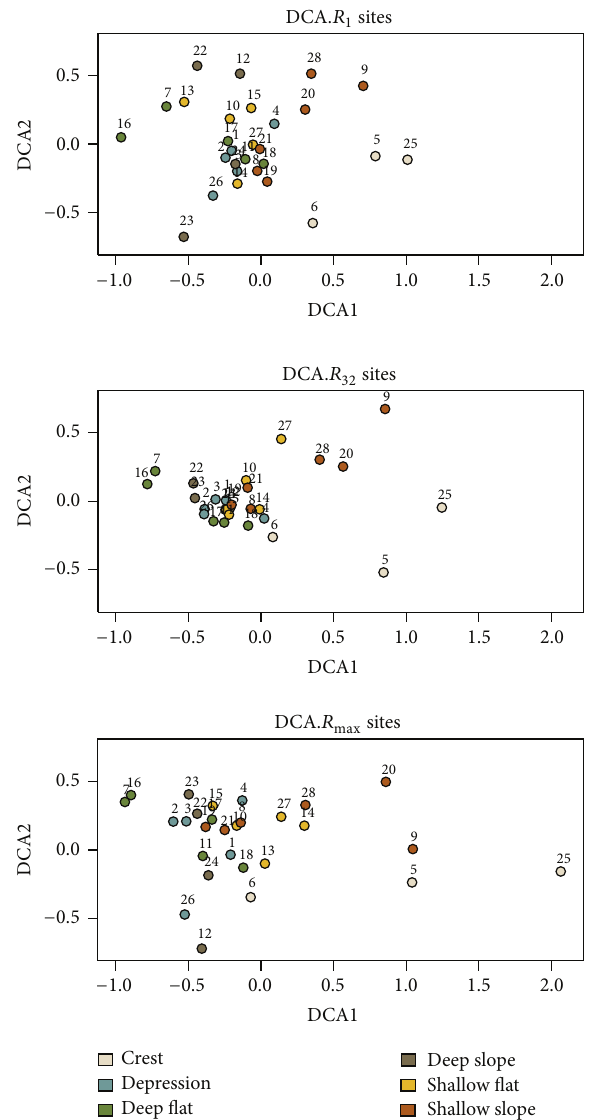
Figure 3: DCA site diagram for axes 1 and 2 for three abundance ranges with no ( 𝑅 1 ), intermediate (𝑅 32 ) , and strong (𝑅 max ) weight given to abundance. Positions of sampled sites 1–28, with affiliation to broad-scaled geomorphological feature indicated by the color of the dot, are shown. DCA axes are scaled in SD units of compositional